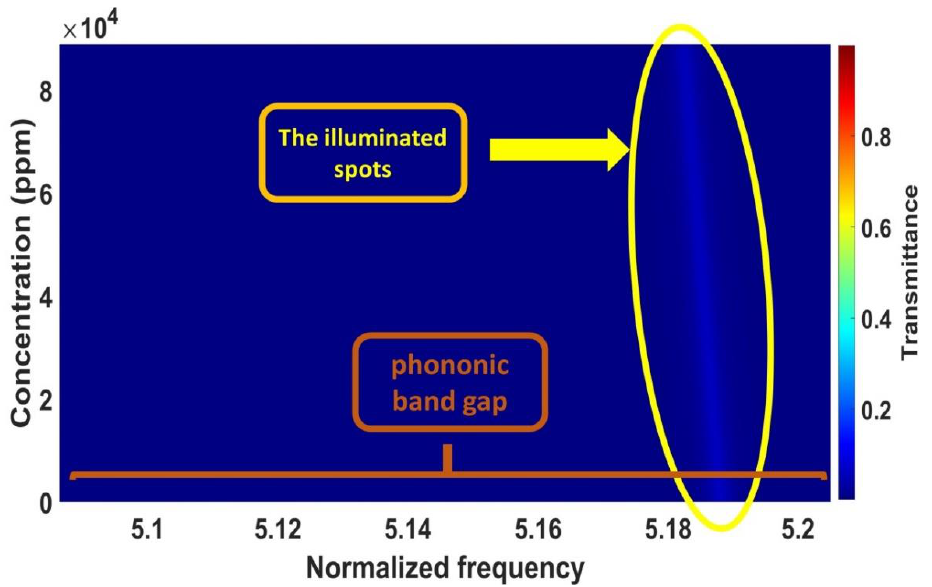
Figure 9. The color map of the transmission distribution versus cadmium bromide concentrations.